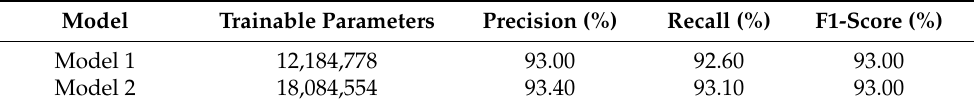
Table 9. Parameters and various accuracy measures of two derived models from